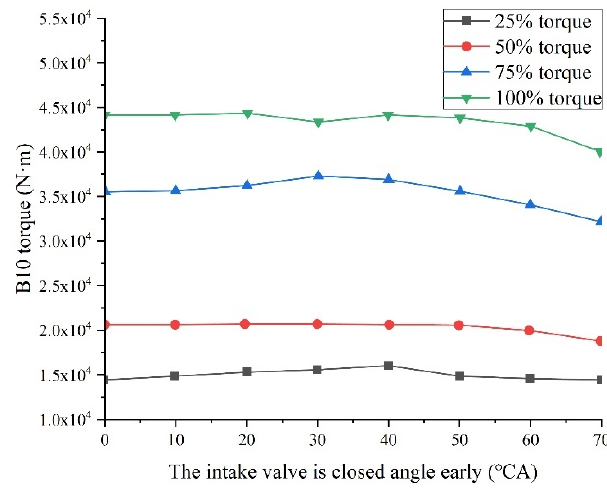
Figure 16. The effect of torque effect when Miller degree > 0.